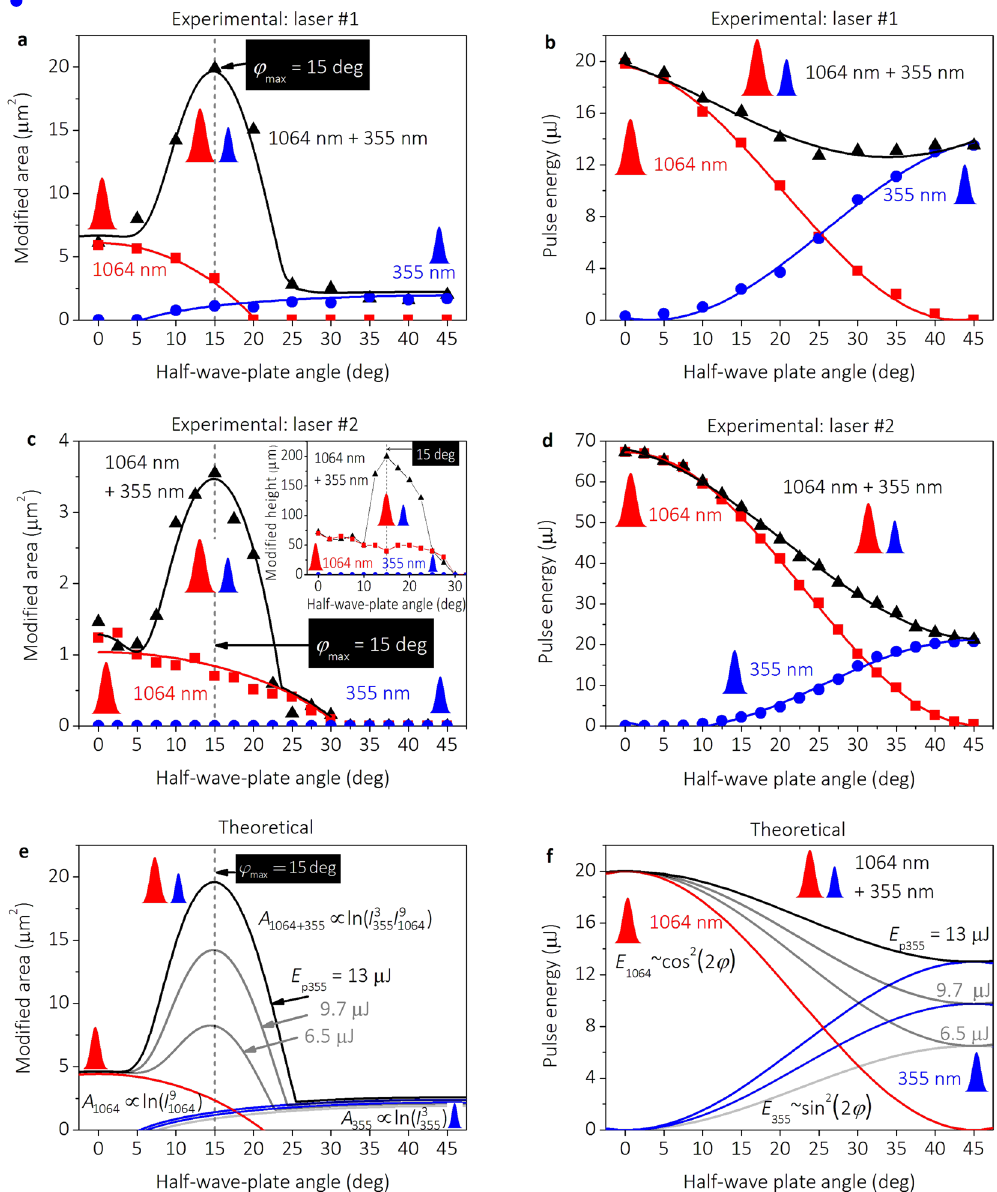
Figure 4. Modification size and pulse energy versus HWP orientation angle. ( a ) Modified area of the intra- volume modification measured in the transverse-plane and ( b ) the pulse energy dependence on the HWP orientation angle: experimental data using the laser source #1. ( c ) Modified area, and ( d ) the pulse energy dependence on the HWP orientation angle: experimental data using the laser source #2. Insert in ( c ) longitudinal modification height dependence on the HWP orientation angle by laser source #2. ( e ) Modified area, and ( f ) pulse energy dependence on the HWP orientation angle: results of the theoretical calculations. Irradiation regimes in ( a , b , c and d ): red solid squares ( )– a single IR pulse at the wavelength of λ = 1064 nm; blue solid dots ( )– a single UV pulse at the wavelength of λ = 355 nm; black solid triangles ( ▲ ) – the dual- wavelength double-pulse irradiation at the wavelengths of λ = 1064 nm and λ = 355 nm with the delay Δ t ≈ 0.1 ns between pulses in the dual wavelength double-pulse pairs (UV prior IR). Solid lines in all graphs represent results of theoretical